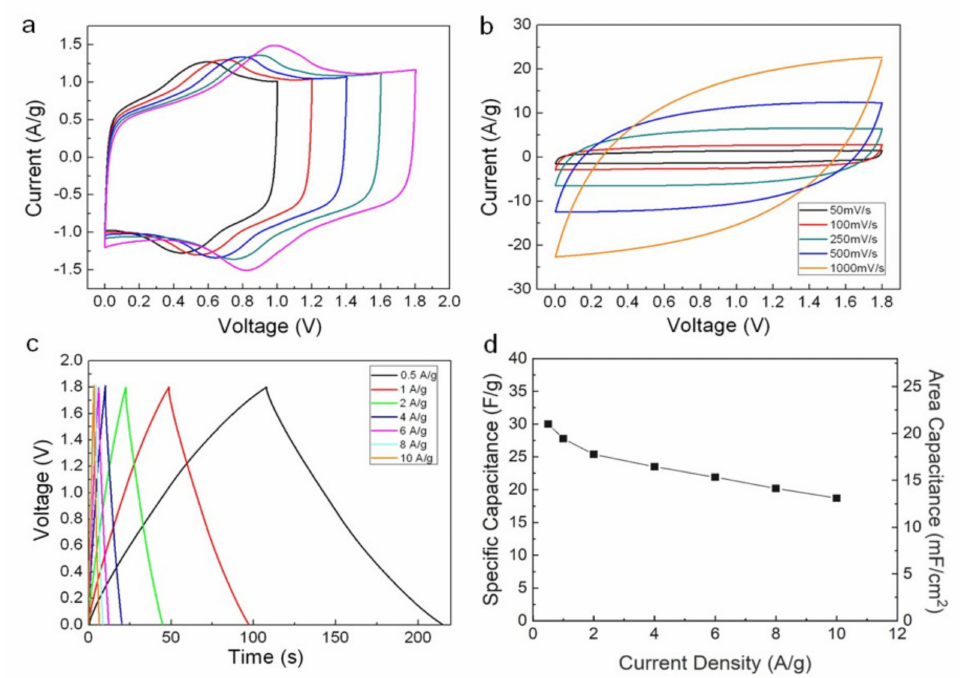
Figure 3. (color online) CV curves obtained for symmetric aqueous SCs employing ACAGSpP electrodes ( a ) with sweep rates of 50 mV/s at maximum voltages of 1, 1.2, 1.4, 1.6, and 1.8 V, respectively, and those ( b ) with sweep rates of 50, 100, 250, 500, and 1000 mV/s at voltages up to 1.8 V; ( c ) Galvanostatic charge and discharge curves, and ( d ) specific capacitances at various current